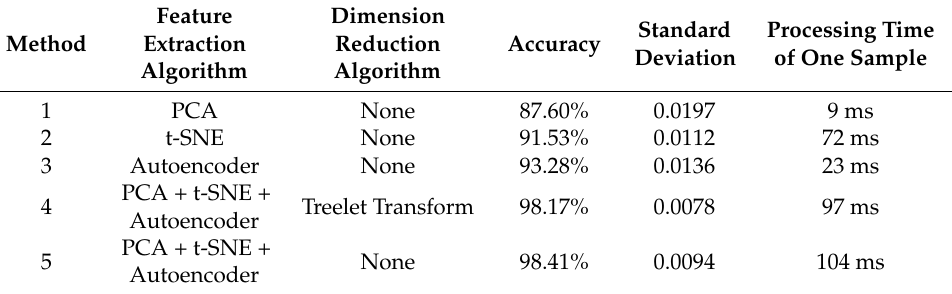
Table 1. Comparison among different